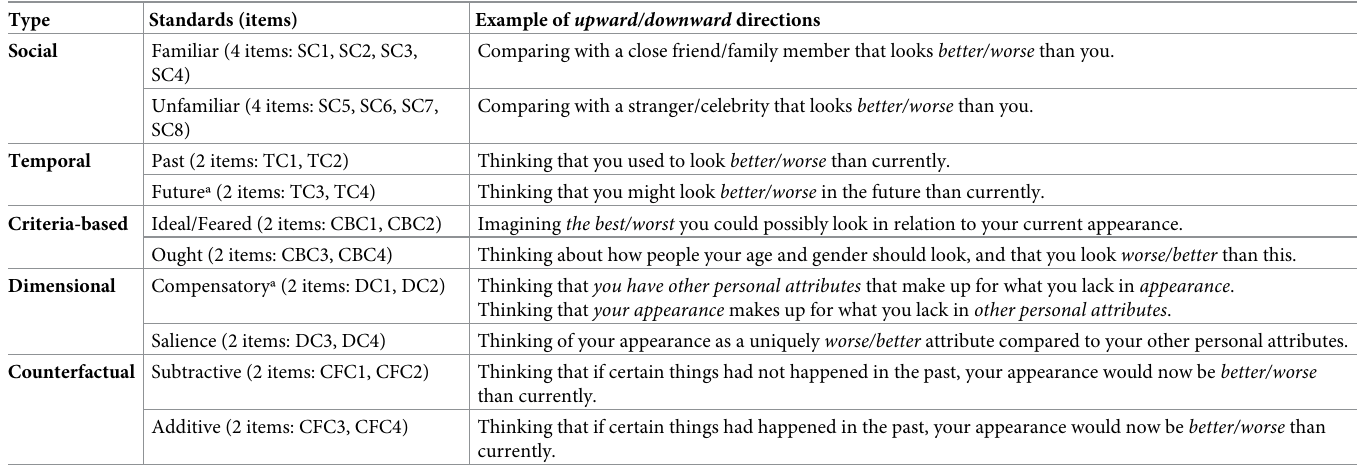
Table 1. Comparison standards and item descriptions for the